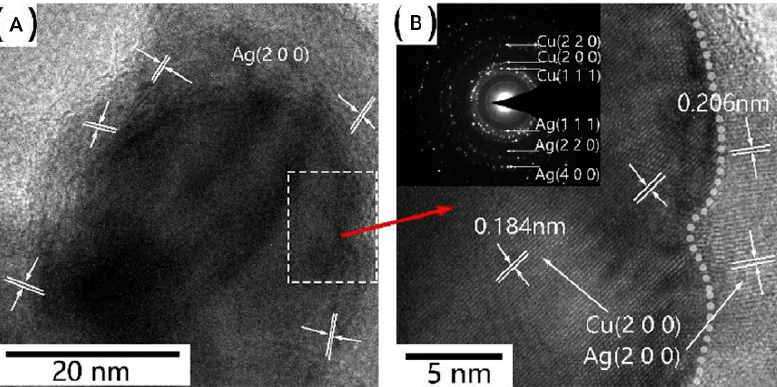
Figure 17. ( A ) HRTEM image of core-shell microstructure, in which Cu is the core, and Ag the shell; ( B ) magnified HRTEM image. Reproduced with permission from Reference [268]. Copyright 2017, Elsevier.